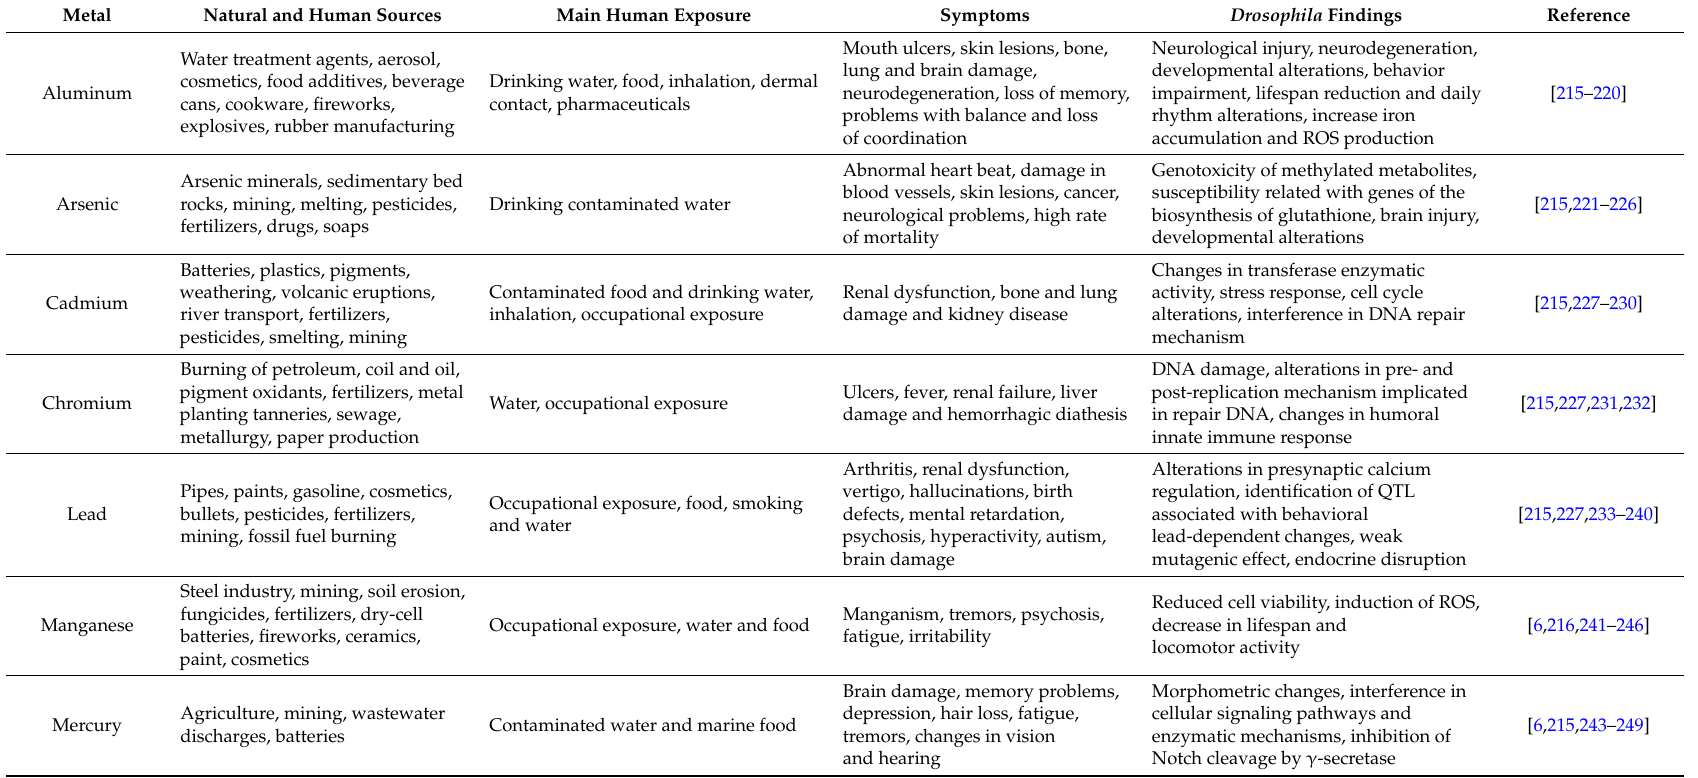
Table 4. Main sources, routes of human exposure, symptoms and contributions of research in Drosophila